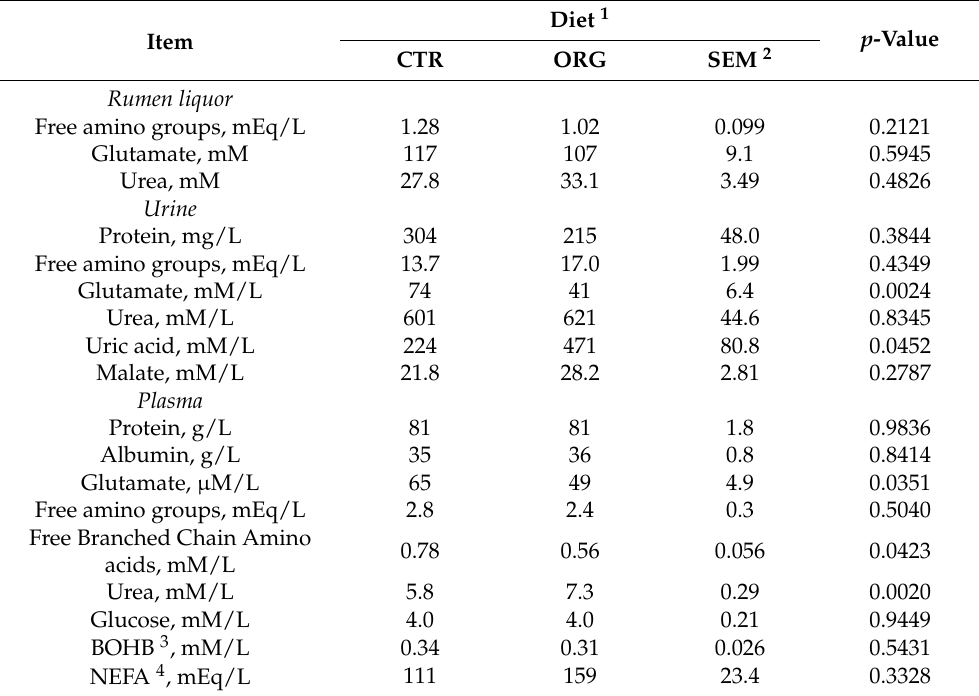
Table 7. Metabolites in rumen liquor, urine, and plasma of Murciano-Granadina dried goats ( n = 10) by the type of